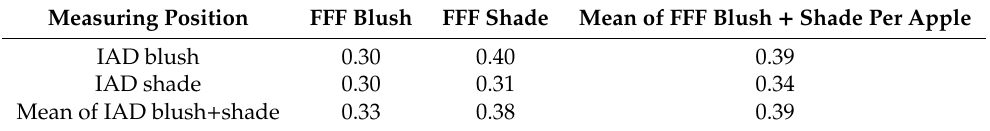
Table 2. Correlation (Pearson r) between IAD assessed at harvest and firmness (FFF) measured after storage of di ff erent cv. ‘Gala’ clones from di ff erent orchards. Correlations are significant at p < 0.005 level (Tukey HSD, p <